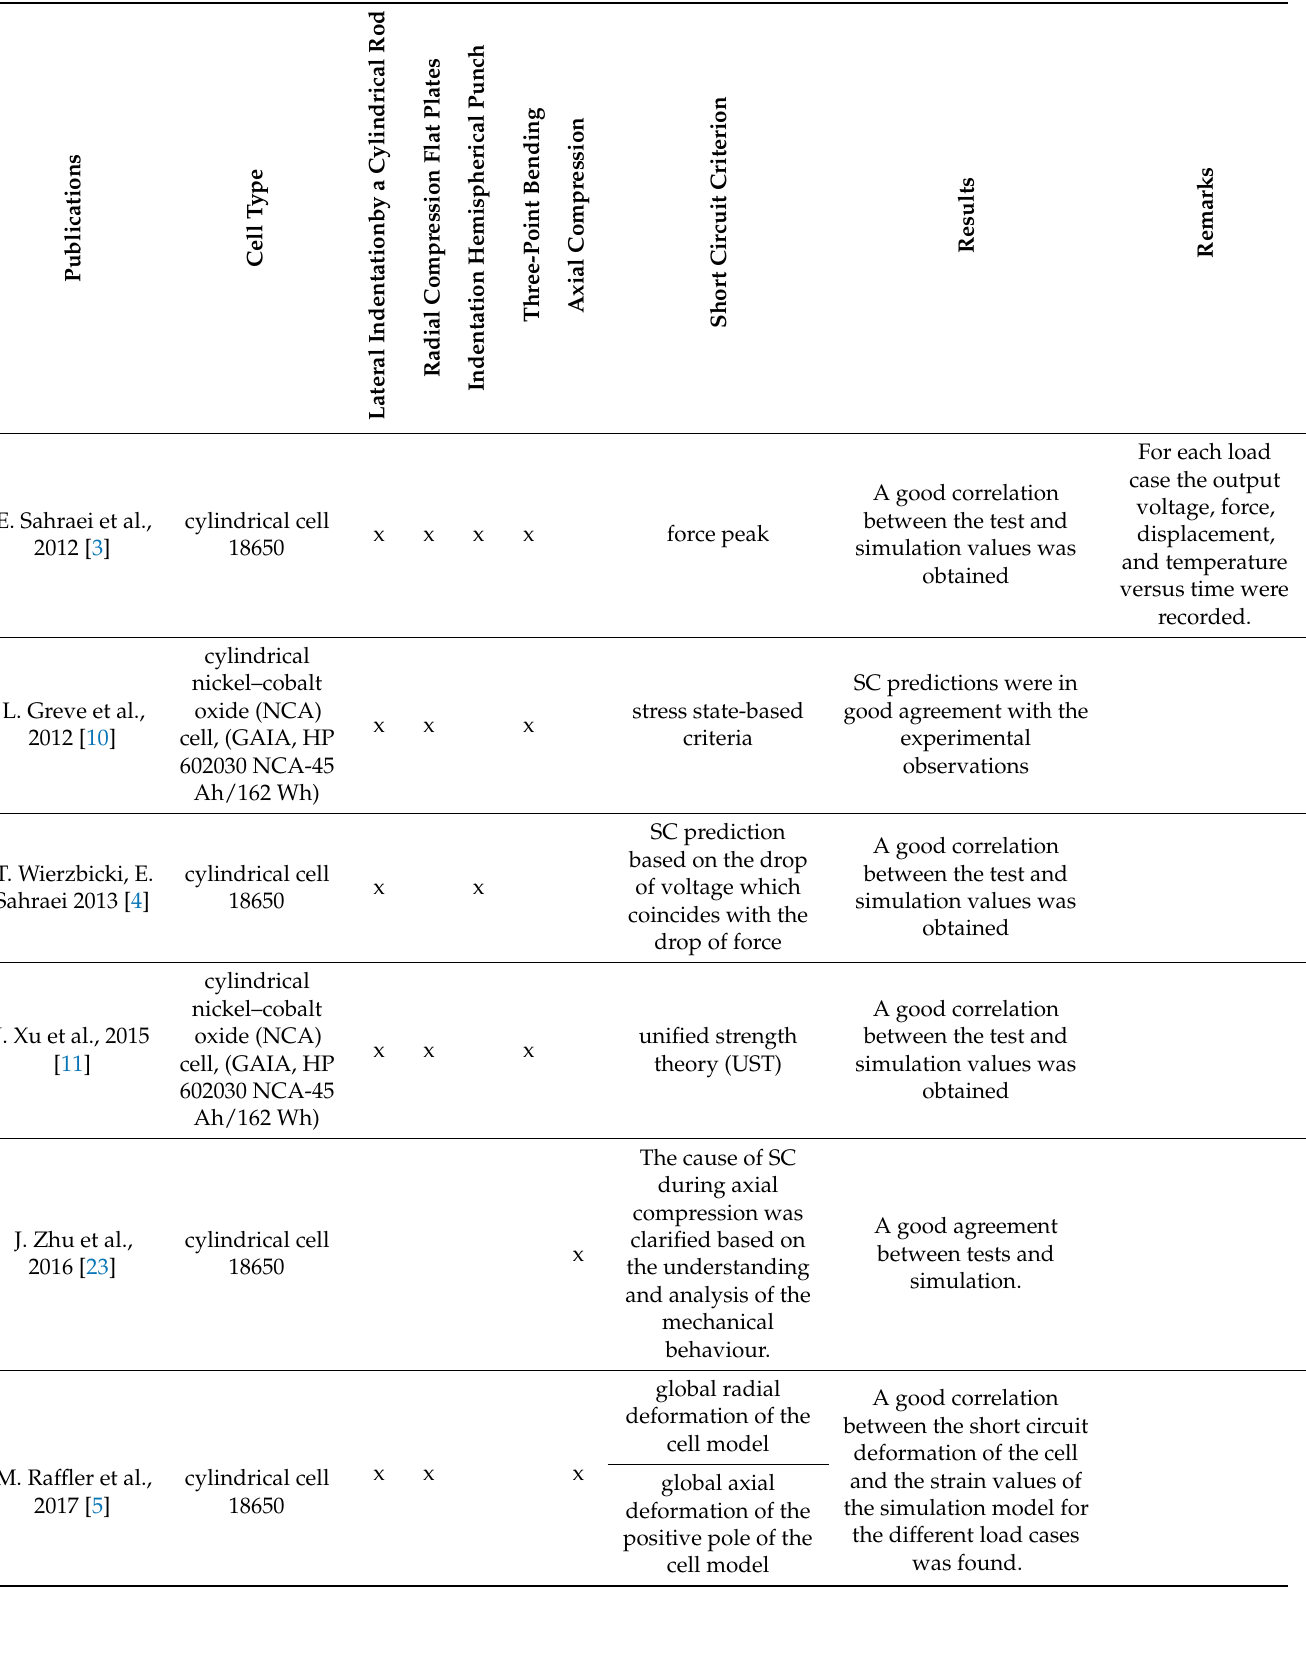
Table A2. Summary of the publications regarding the short circuit prediction due to mechanical deformations.